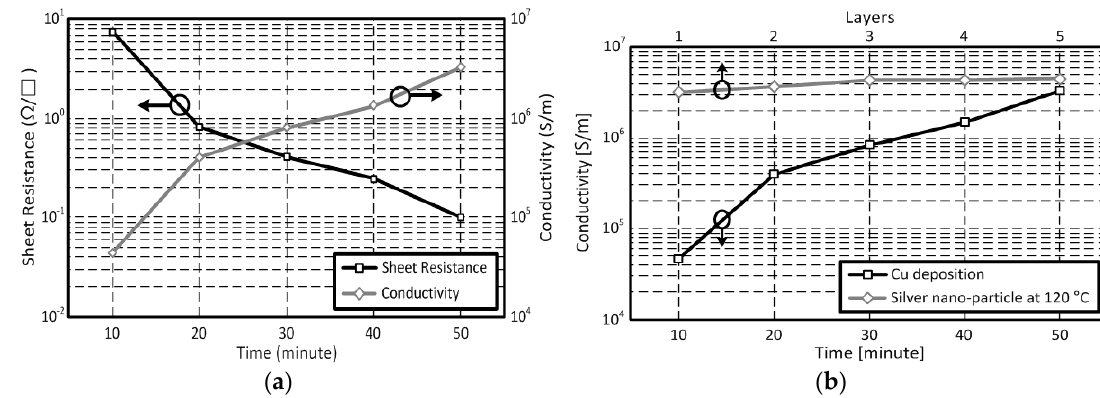
Figure 7. ( a ) Sheet resistance and conductivity values of the grown copper layer as a function of the immersion time in the copper bath and ( b ) conductivity values of the grown copper layer and the inkjet- printed silver nano-particle as a function of the development time in the copper bath and the printed layers.